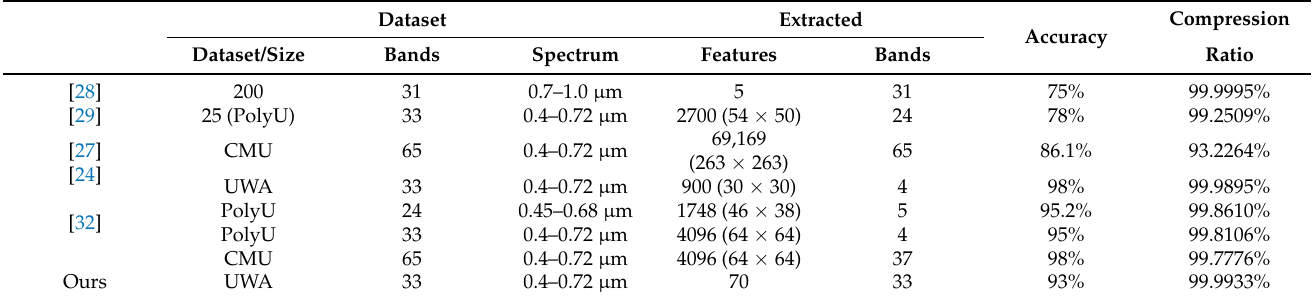
Table 2. Comparison of hyperspectral face recognition accuracy and compression